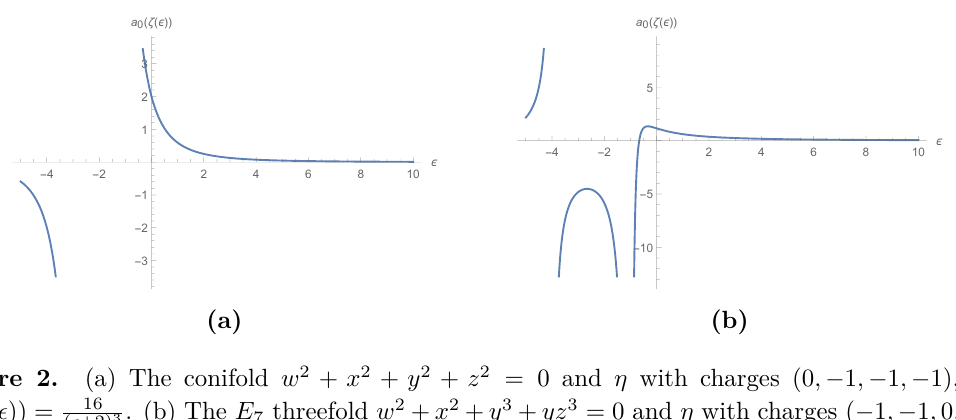
Figure 2. (a) The conifold w 2 + x 2 + y 2 + z 2 = 0 and η with charges (0 , − 1 , − 1 , − 1) , and a 0 ( ζ ( (cid:15) )) = 16 . (b) The E 7 threefold w 2 + x 2 + y 3 + yz 3 = 0 and η with charges ( − 1 , − 1 , 0 , − 1) , ( (cid:15) +2) 3 and a 0 ( ζ ( (cid:15) ))